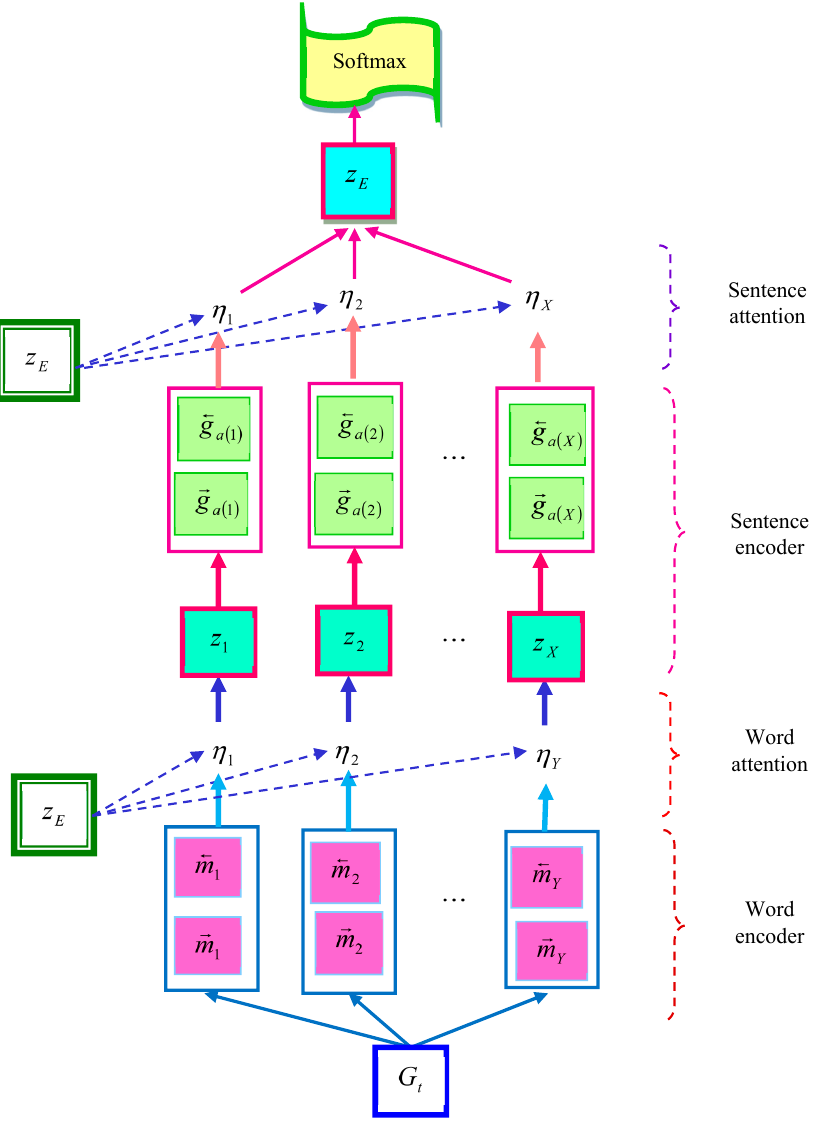
Figure 3. An illustration of Hierarchical Attention Network (HAN). (c) Sentence encoder: The document vector was derived and the bidirectional GRU was employed for encoding the sentences with sentence